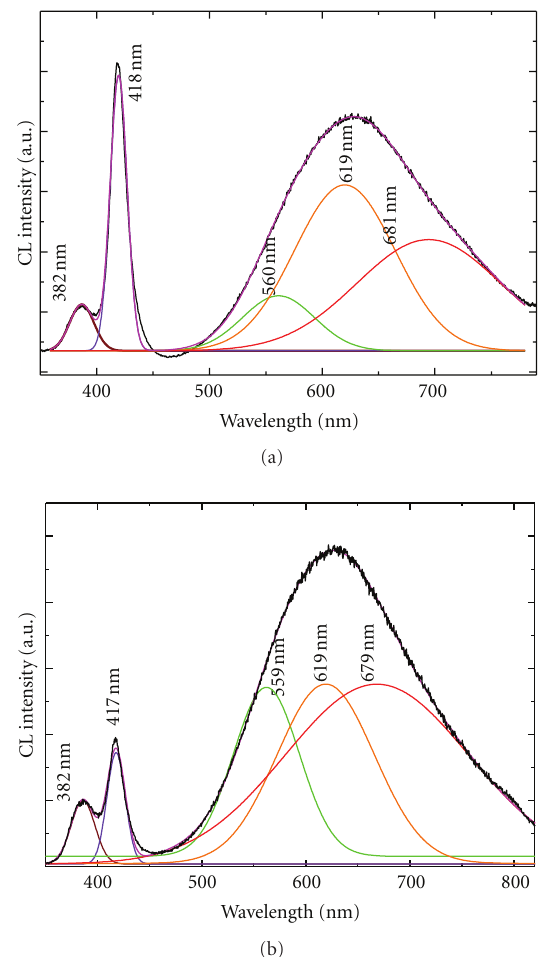
Figure 6: (a) CL spectra of ZnO NTs after the Gaussian fitting. (b) CL spectra of ZnO NRs after the Gaussian